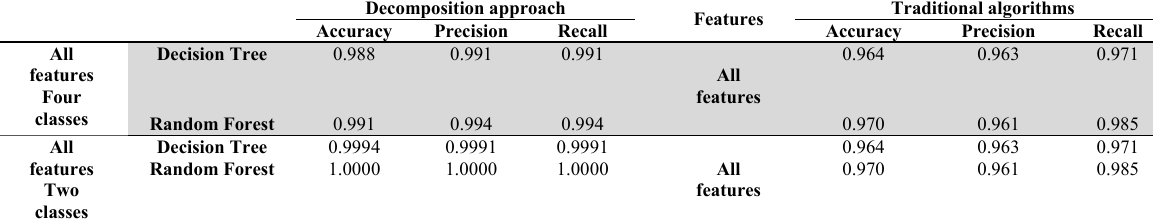
Comparison of the accuracy in the first and second phases before feature selection Decomposition approach